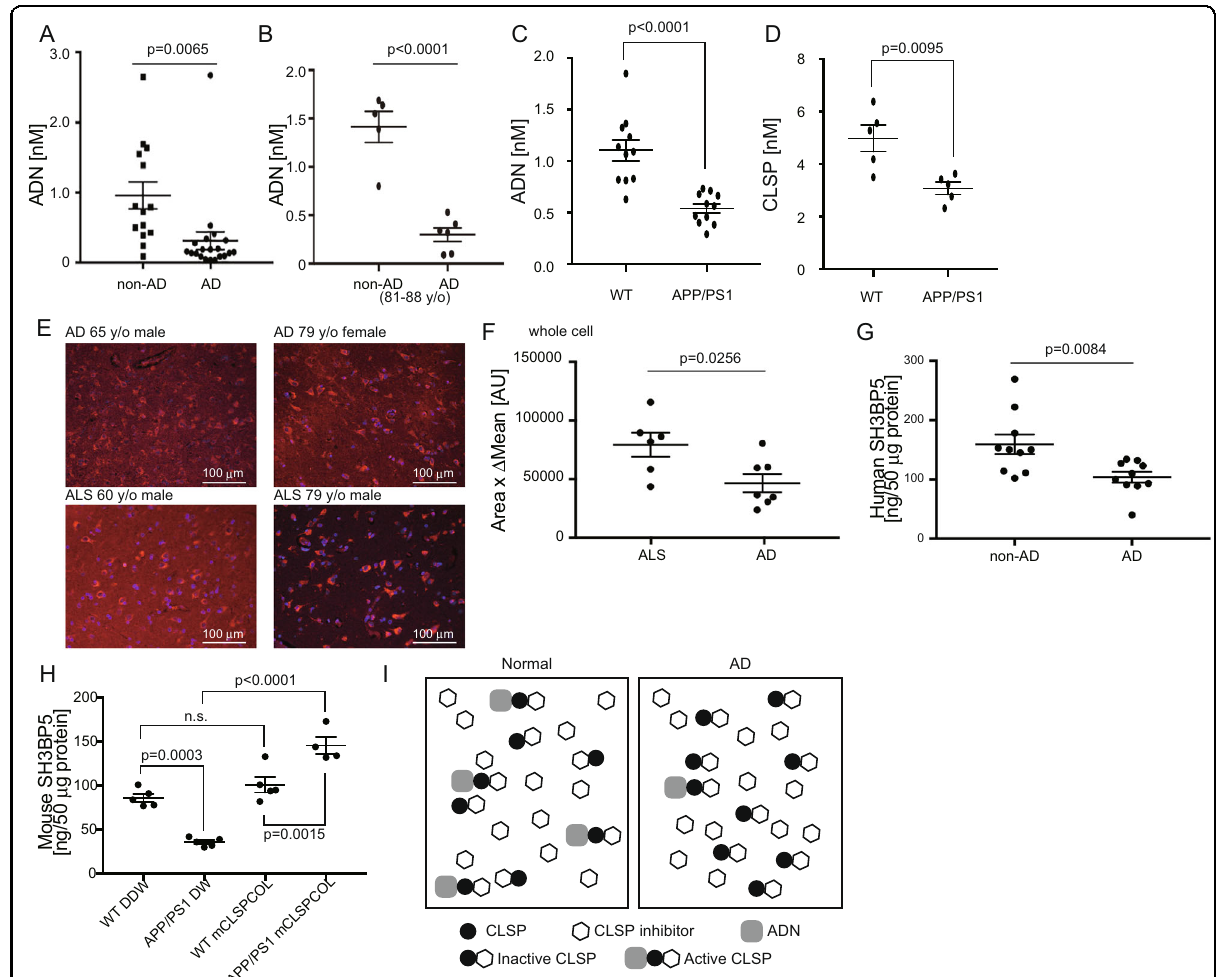
Fig. 4 The levels of brain adiponectin and intraneuronal SH3BP5 are reduced in AD patients and aged APP/PS1 mice. a CSF adiponectin (ADN) concentrations in AD and non-AD patients (Supplementary Table S1) are shown as dots ( N = 20 for AD, N = 14 for non-AD) with means ± SEM of adiponectin concentrations (AD, 0.31 ± 0.13 nM; non-AD, 0.96 ± 0.19 nM; unpaired t -test, p = 0.0065). b CSF adiponectin concentrations in AD and non-AD patients aged 81 – 88 years (Supplementary Table S3) are shown as dots ( N = 6 for AD, N = 5 for non-AD) with means ± SEM of adiponectin concentrations (AD, 0.30 ± 0.07 nM; non-AD, 1.41 ± 0.16 nM; unpaired t -test, p < 0.0001). c Adiponectin concentrations in the ISFs of aged male wt littermate and APP/PS1 mice (16-month-old; N = 11 for each group) are demonstrated as dots with means ± SEM of adiponectin concentrations (wt, 1.10 ± 0.10 nM; APP/PS1, 0.54 ± 0.05 nM; unpaired t -test, p < 0.0001). d CLSP concentrations in the ISFs of aged male wt littermate and APP/PS1 mice (16-month-old; N = 5 for each group) are demonstrated as dots with means ± SEM of mouse CLSP concentrations (wt, 4.99 ± 0.51 nM; APP/PS1, 3.08 ± 0.24 nM; unpaired t -test, p = 0.0095). e Outer pyramidal layers of temporal or occipital lobes from two AD patients (65-year-old, male; 79-year- old female) and two ALS patients (66-year-old, male; 79-year-old, male) were immunostained with the antibody to SH3BP5. Scale bars, 100 μ m. The speci fi city of the SH3BP5 antibody was con fi rmed as shown in Supplementary Fig. S12A. f Immuno fl uorescence intensities in sections of outer pyramidal layers of temporal or occipital lobes from AD patients and ALS patients are shown as dots ( N = 7 for AD, N = 6 for ALS) with mean ± SEM of immuno fl uorescence intensities (AD, 46564 ± 7737 arbitrary unit; ALS, 79225 ± 10305 arbitrary unit; unpaired t -test, p = 0.0256). g SH3BP5 concentrations in cell-broken lysates, derived from temporal cortices of AD and non-AD patients listed in Supplementary Tables S6 and S7, were measured using the SH3BP5 ELISA system. Amounts of SH3BP5 in 50 μ g of lysates of AD and non-AD patients are shown ( N = 10 for each group) with their means ± SEM (AD, 103.9 ± 9.0 ng; non-ADs, 159.4 ± 16.5 ng; unpaired t -test, p = 0.0084). h Distilled water (DW) or 5 nmol of mouse CLSPCOL was subcutaneously injected into aged male APP/PS1 and wt littermate mice (16-month-old; N = 5 for each group). Twenty- fi ve hr after the injection, mice were sacri fi ced for the measurement of SH3BP5 concentrations. Amounts of SH3BP5 in 50 μ g of cell-broken lysates are shown with their means ± SD (wt + DDW, 88.2 ± 4.5 ng; APP/PS1 + DDW, 35.8 ± 2.2 ng; wt + CLSPCOL, 101.0± 8.6 ng; APP/PS1 + CLSPCOL, 145.8 ± 9.5 ng; one-way ANOVA followed by post hoc Tukey test). i Schematic diagrams for molecular ratios of CLSP, adiponectin, and a CLSP inhibitor in AD vs normal